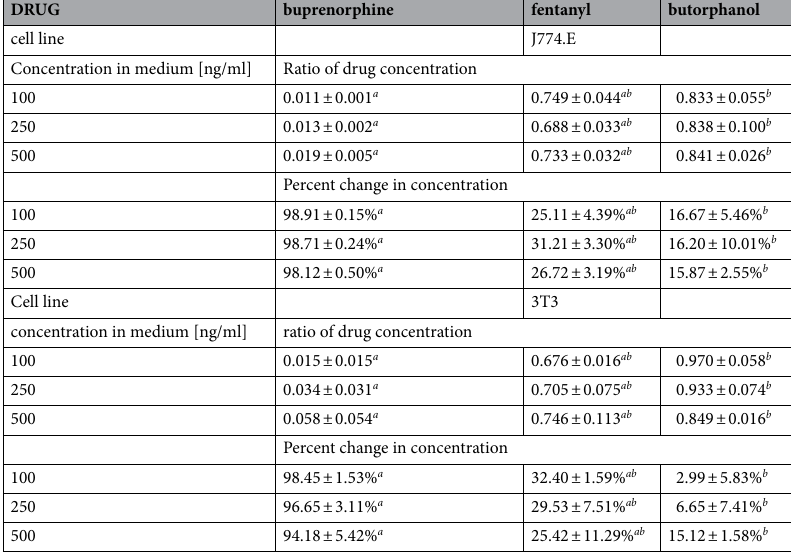
Table 4. The ratio of drug concentration evaluated in the cells in Intralipid positive group and Intralipid free group (n = 3), as well as percent change in the concentration caused by the Intralipid addition. The results are presented as mean ± standard deviation. Values in a row that do not share a superscript letter are considered statistically different ( p < 0.05). No differences were found between tested concentrations and cell lines used within the same drug for every tested